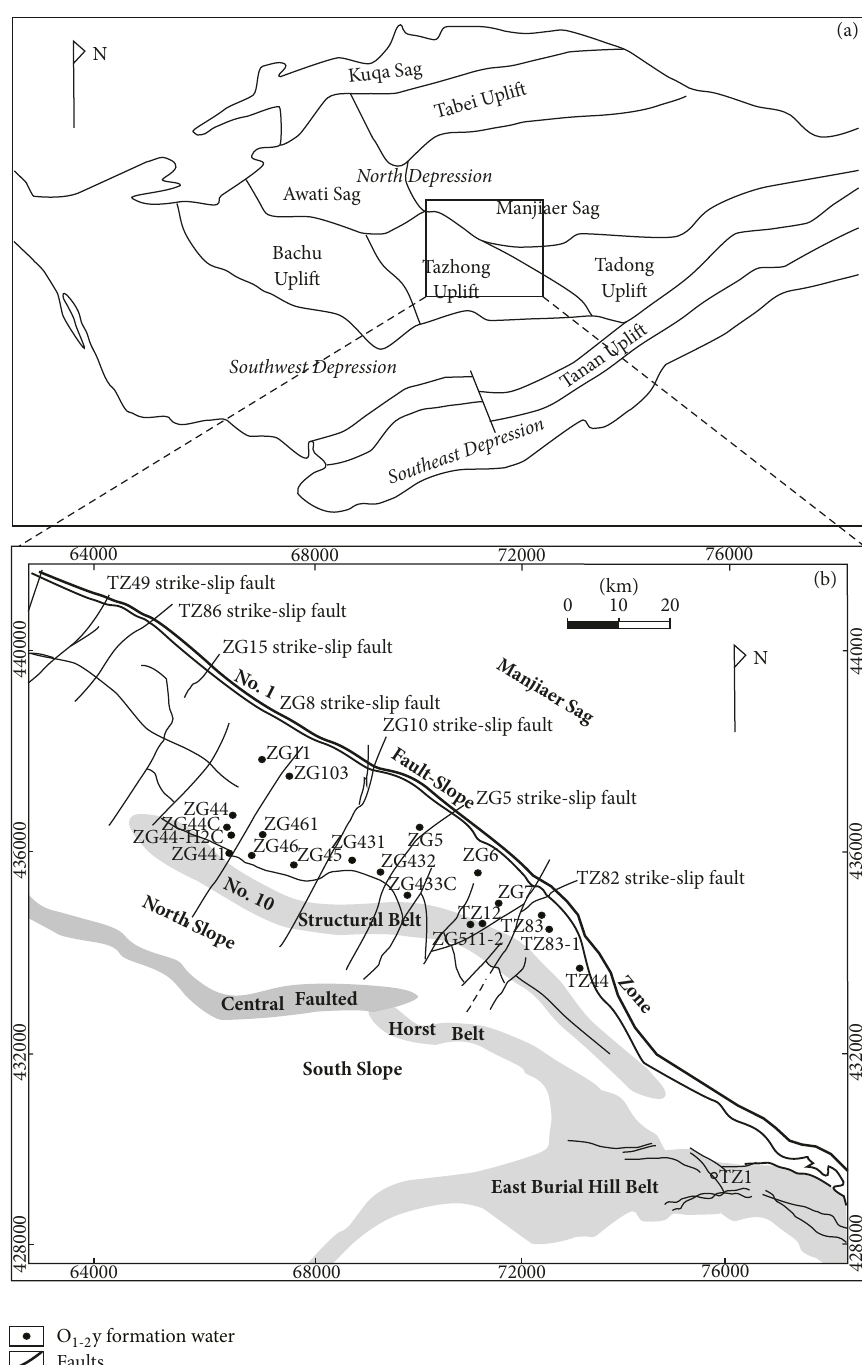
Figure 1: (a) Map of the Tarim Basin showing tectonic units and location of Tazhong Uplift; (b) map of the study area showing geological tectonics and location of wells from where formation waters were